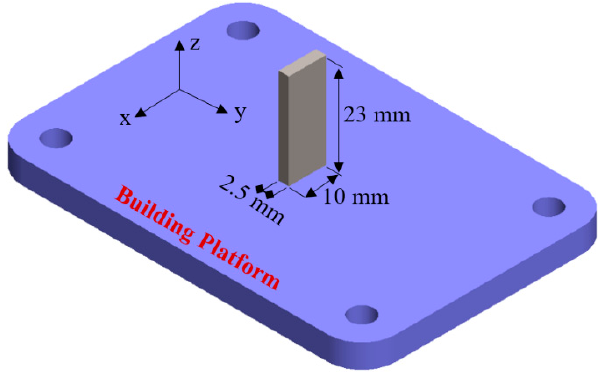
Figure 2. Schematic of the test sample. The x–z surfaces were exposed to the slurry stream.